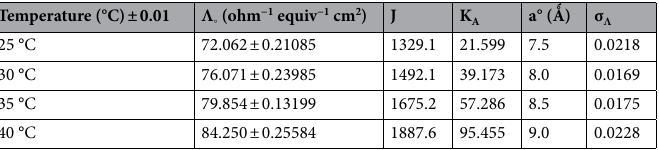
Table 3. The characteristic parameters for Sodium N , N -Dimethyl from Eq. (4) at pressure 1 atm.